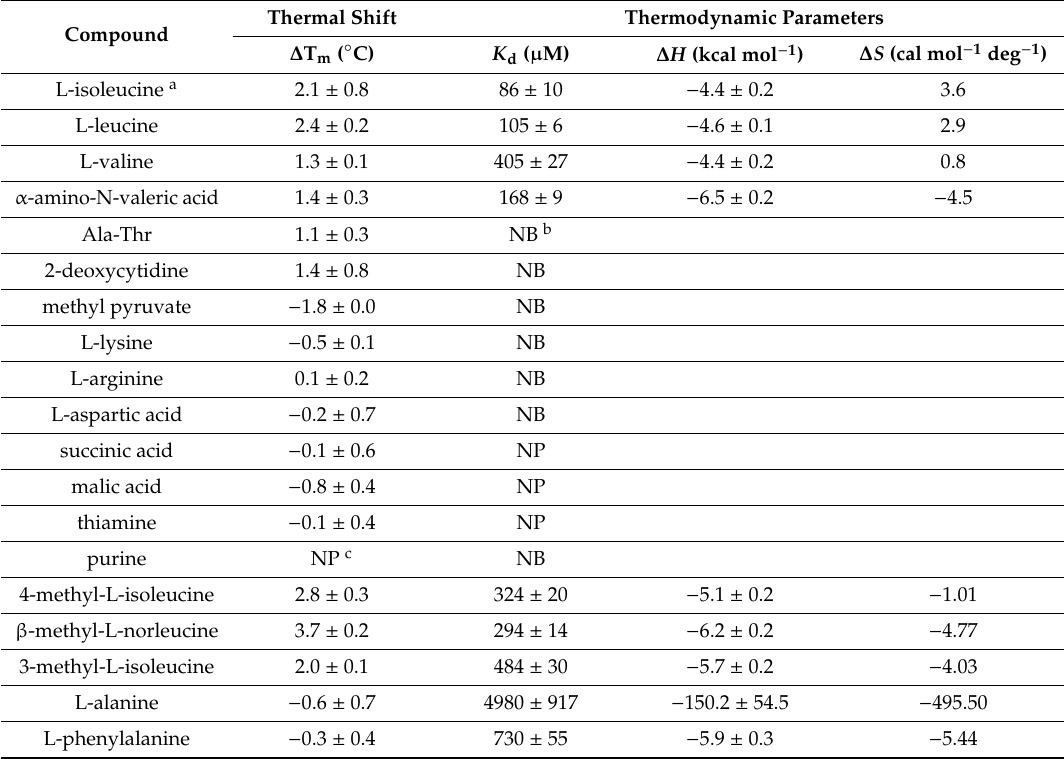
Table 4. Thermal shift assay data and thermodynamic parameters of ligand binding derived from isothermal titration calorimetry (ITC)